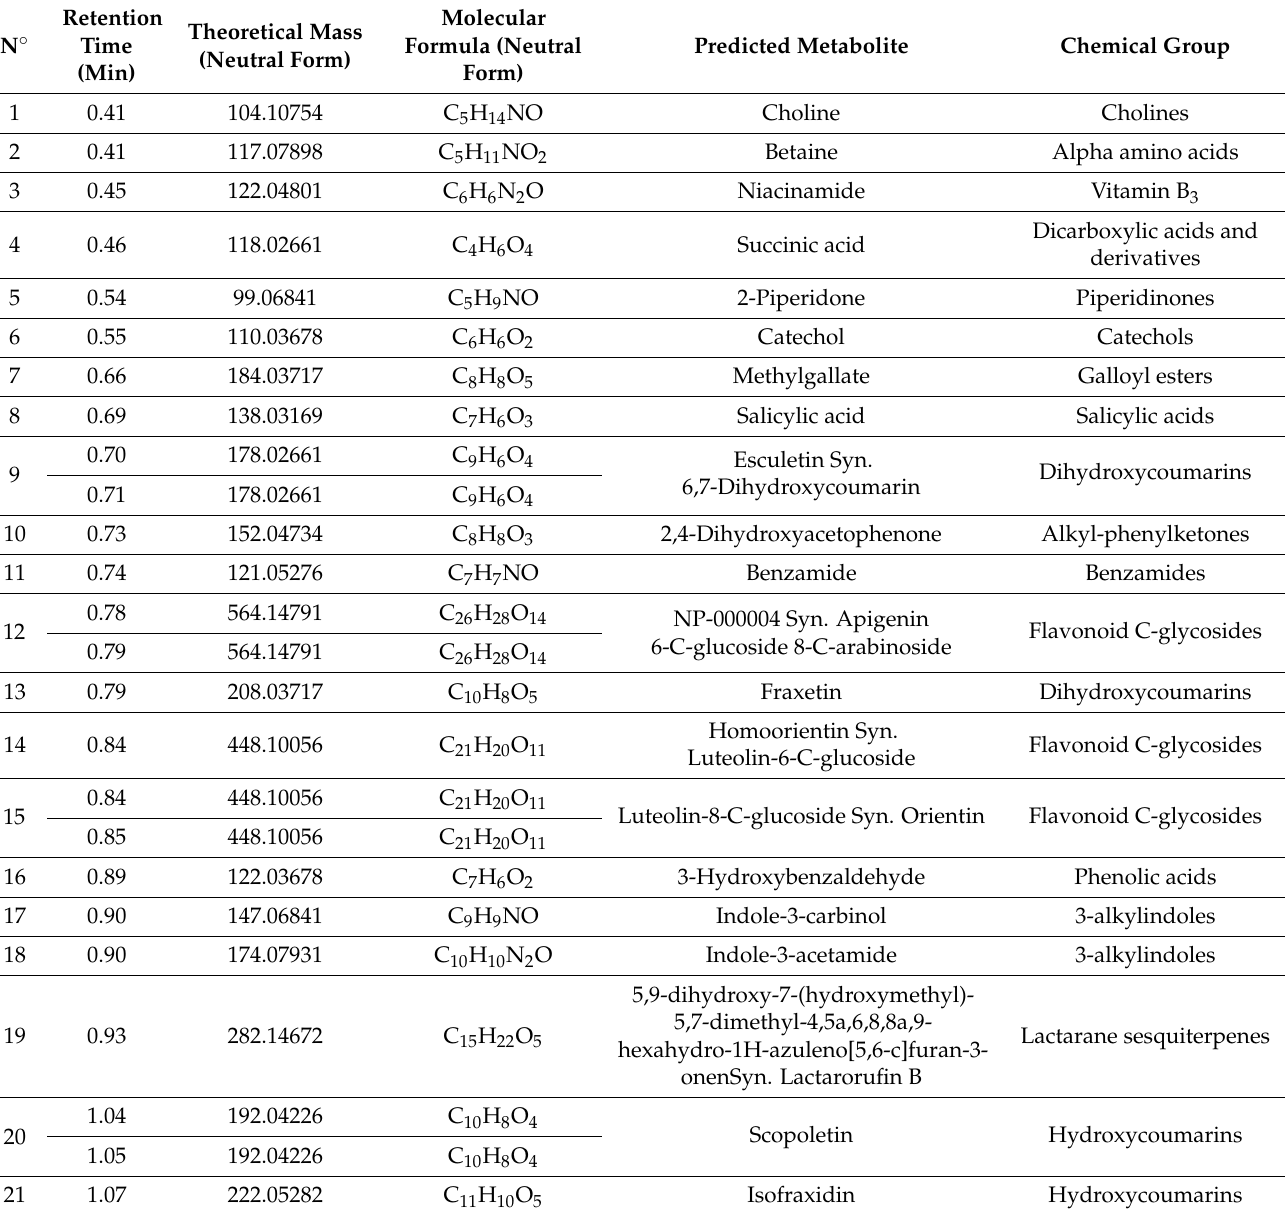
Table 2. Phytochemical constituents of leaves of J. macrantha ethyl acetate fraction determined by